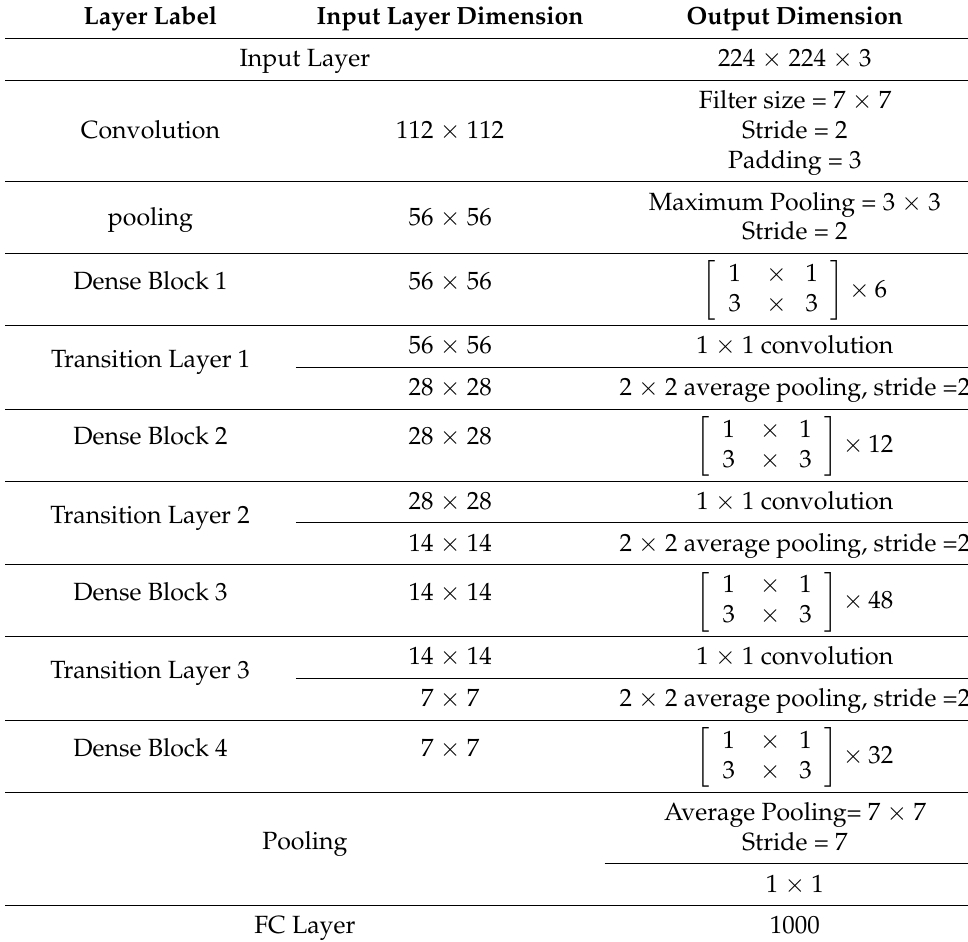
Table 3. The dimensions of the various layers of DenseNet-201